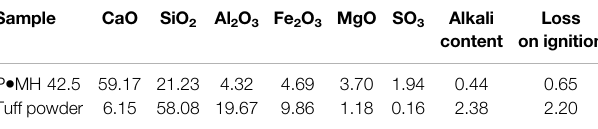
TABLE 1 | Chemical compositions of cement and tuff powder (wt.%).